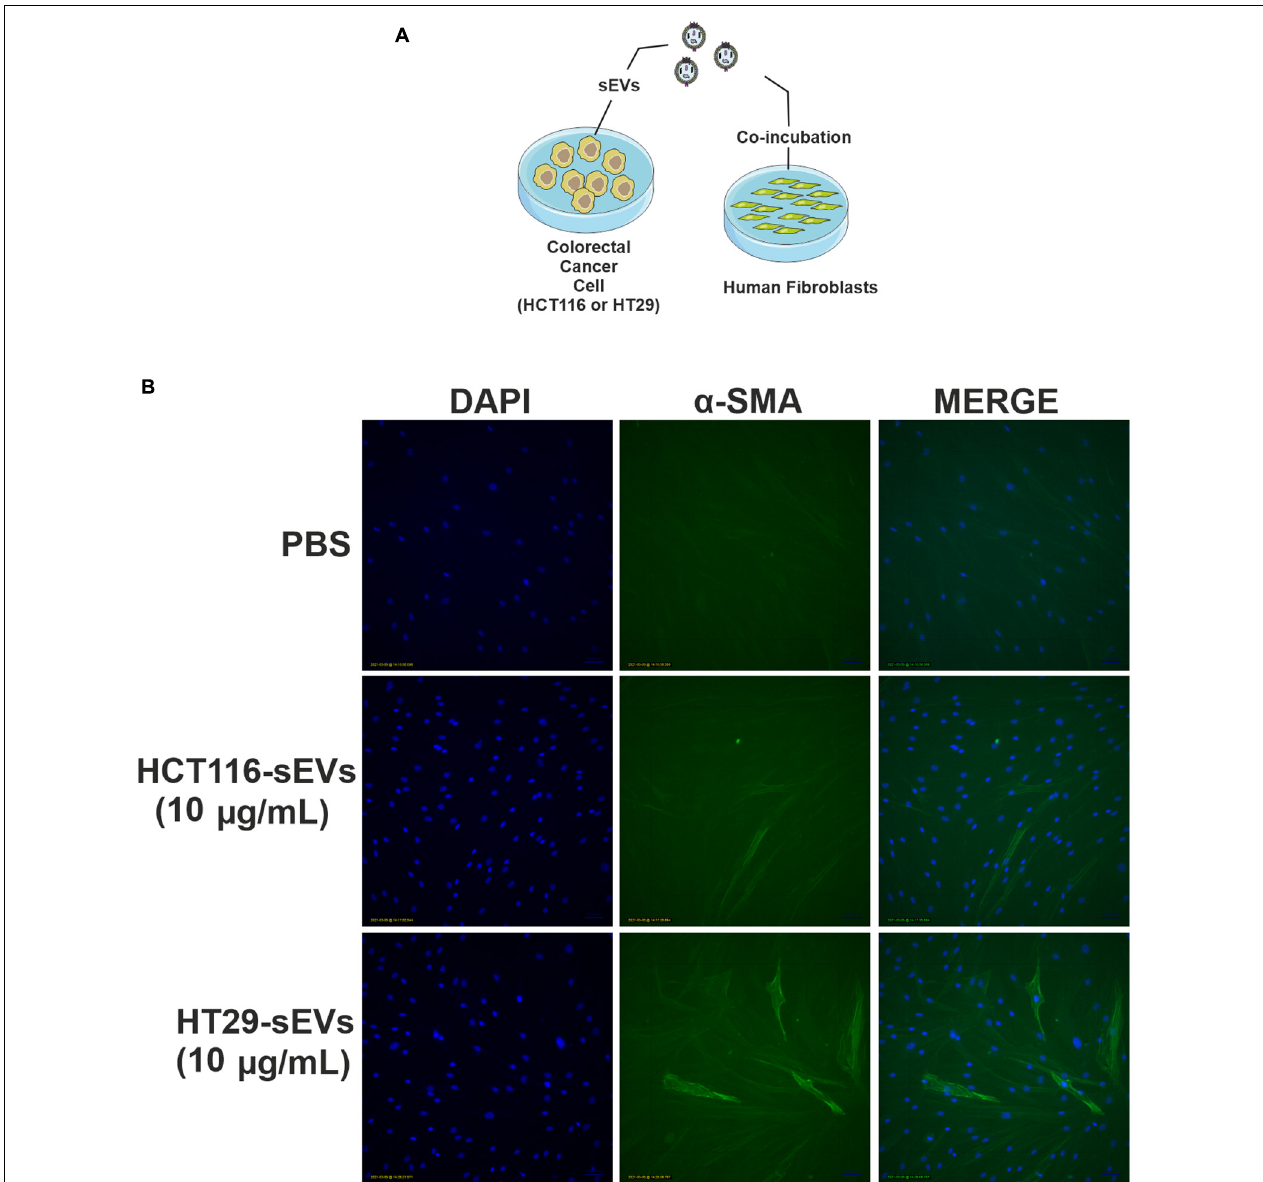
FIGURE 6 | HCT116 and HT29 cell-derived sEVs activate and transform human fibroblasts. (A) Schematic diagram of the experimental procedures. (B) Fluorescent microscopic analysis of α -SMA (green) expression in human fibroblasts exposed to HCT116 and HT29 cell-derived sEVs (10 µ g/ml) or vehicle (PBS) for 48 h. Nuclei were stained with 4 (cid:48) ,6-diamidino-2-phenylindole (blue). Scale bar: 100 µ